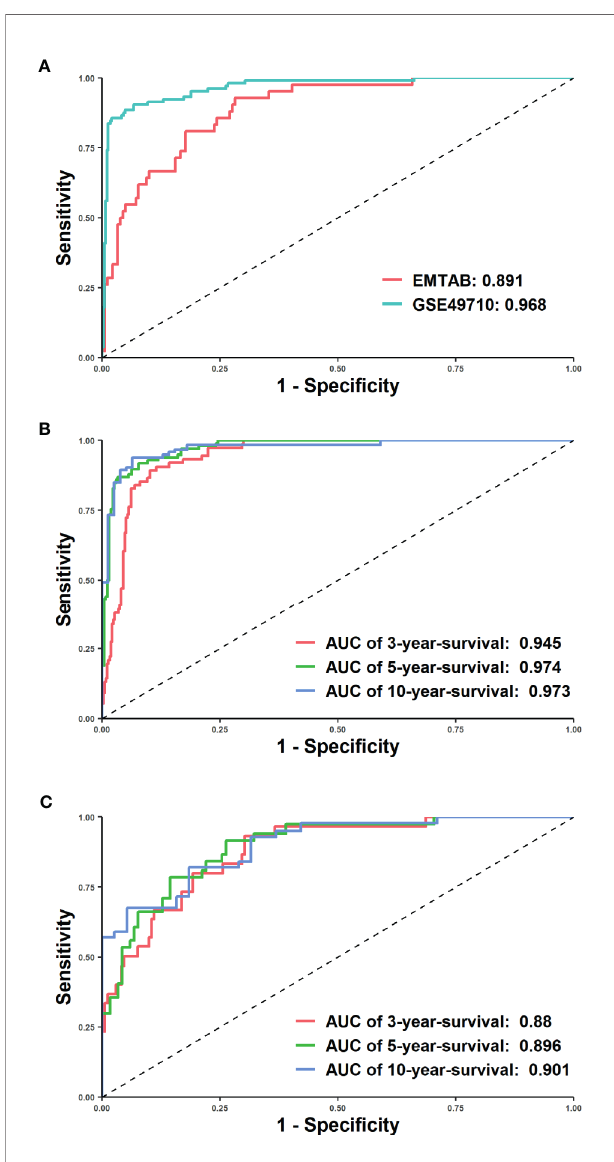
FIGURE 3 | Receiver operating characteristic (ROC) curves demonstrated the superiority of our model. X-axis represented false positive rate (1-speci fi city) and y axis represented true positive rate. (A) The ROC curves of the EMTAB (coralline line) and GSE46960 (atroceruleous line) cohort. (B, C) 3-year, 5-year and 10-year time-dependent ROC curves of the GSE46960 (B) and EMTAB (C)